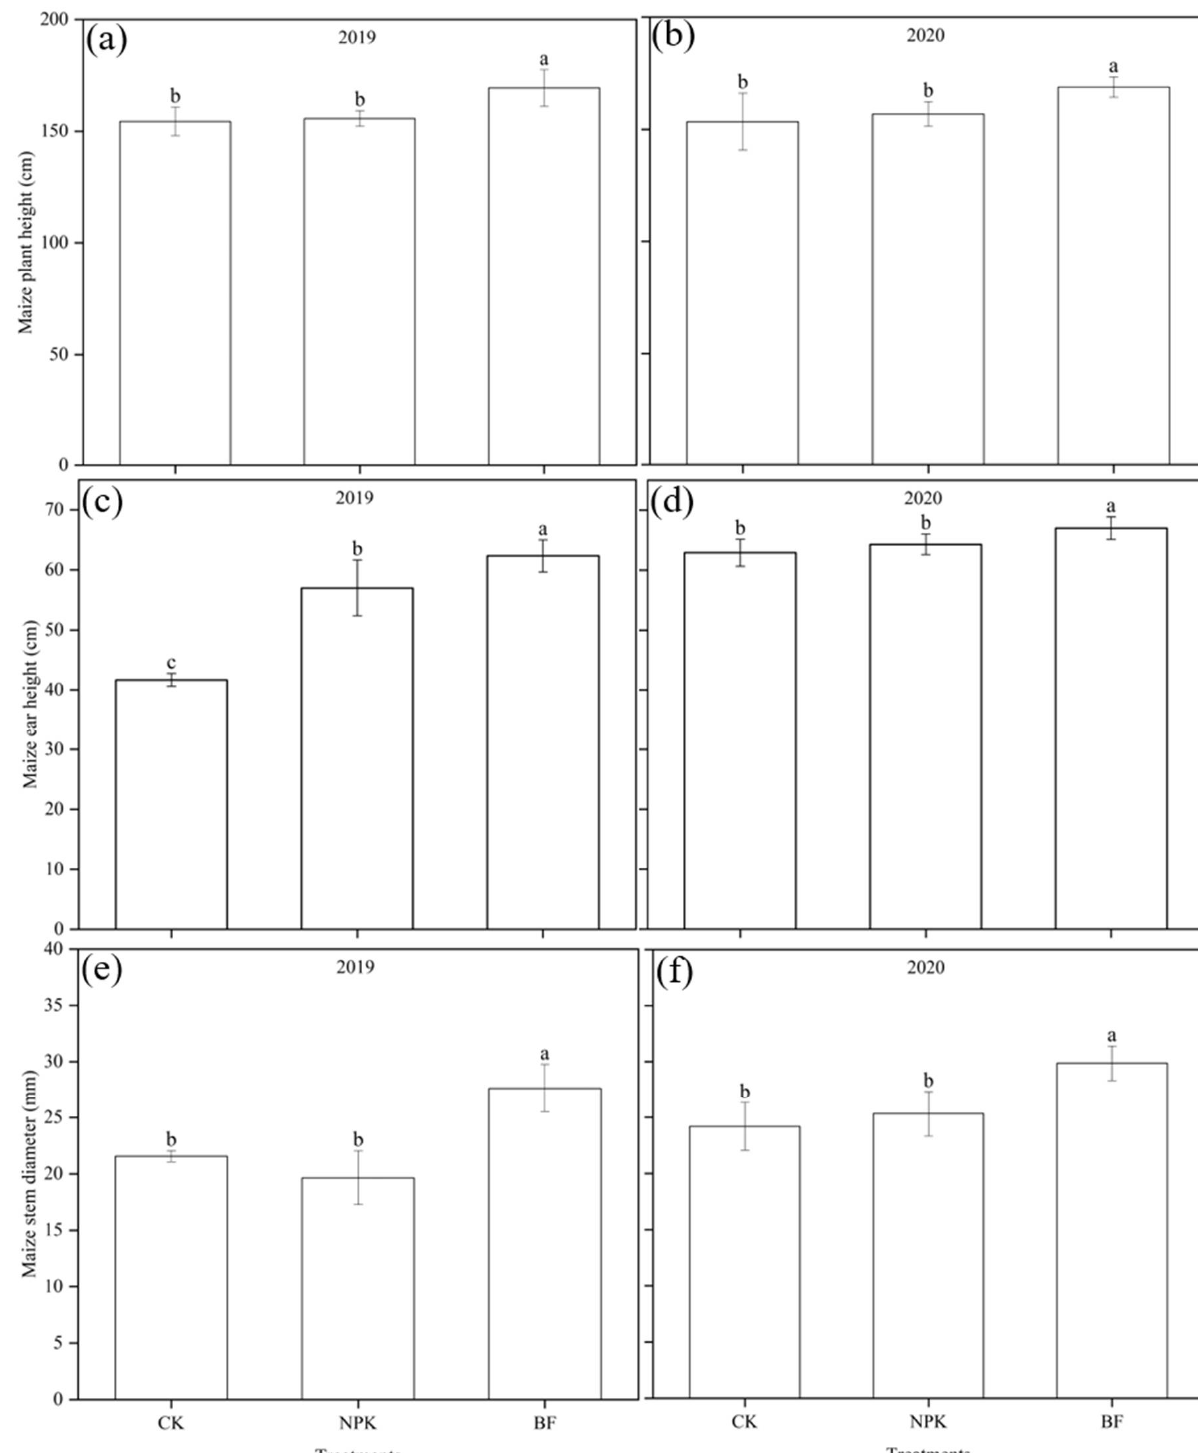
Figure 2. Growth-related traits of maize in 2019–2020 under different N treatments. ( a ), Plant height of maize in 2019. ( b ), Plant height of maize in 2020. ( c ), Ear height of maize in 2019. ( d ), Ear height of maize in 2020. ( e ), Stem diameter of maize in 2019. ( f ), Stem diameter of maize in 2020. The error bars show the standard deviations of the means (n = 3). Different lowercase letters indicate significant differences among treatments ( p < 0.05).